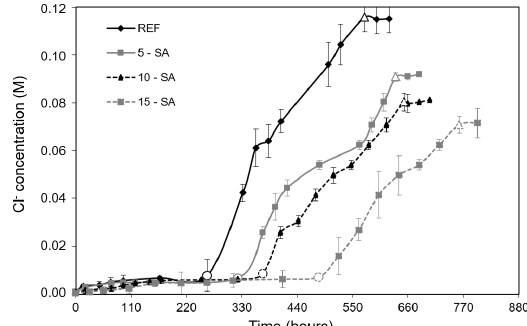
Figure 9. Chloride concentration in the anodic cell solution as a function of time for the concrete specimens with 0%, 5%, 10%,